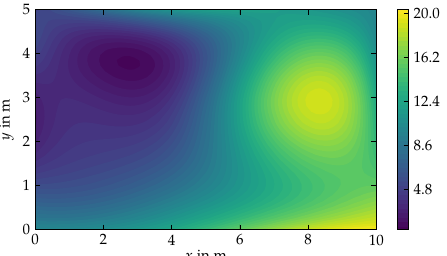
Figure 10. The concentration field used for generating